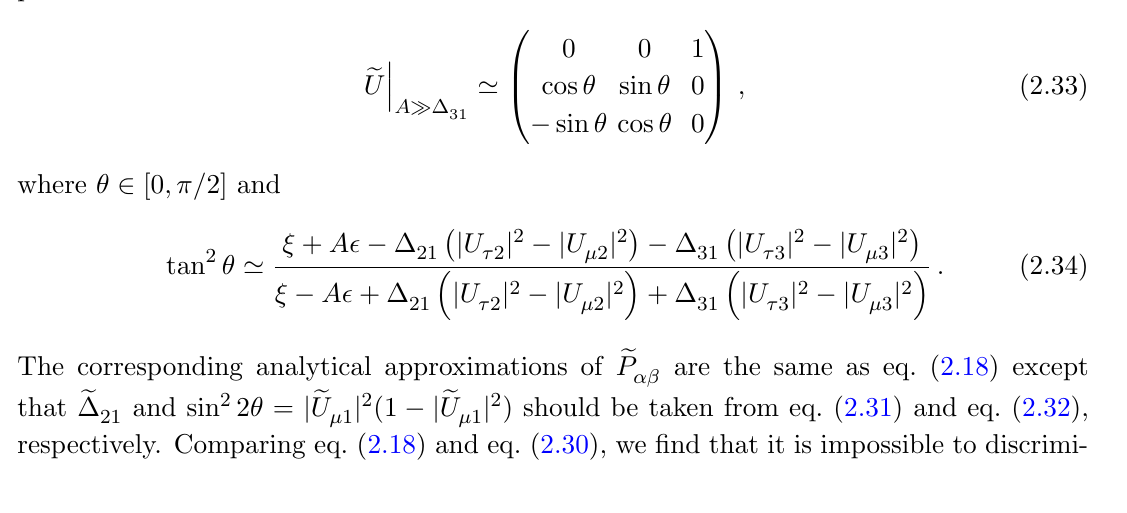
Figure 6 . In the standard three-(cid:13)avor mixing scheme, the illustration of how (cid:22); (cid:28) and i = 1 ; 2 ; 3) evolve with the matter e(cid:11)ect parameter A in the case (IMO ; (cid:23) ) with or without radiative corrections, where the best-(cid:12)t values of ( (cid:18) been